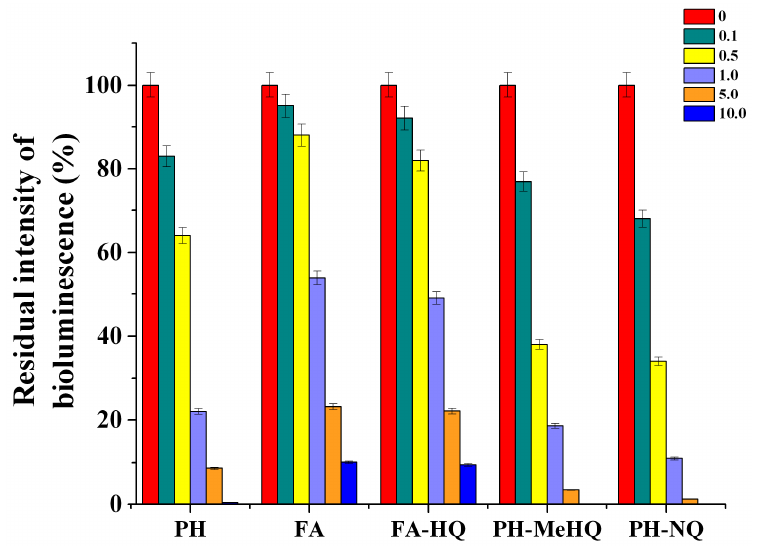
Figure 3. The residual bioluminescence intensity of immobilized P. phosphoreum B-1717 cells in presence of various concentrations (g / L) of di ff erent types of HC. Basically the di ff erence in the mean values among the treatment groups was statistically significant according one-way ANOVA (one-way analysis of variance) ( p <